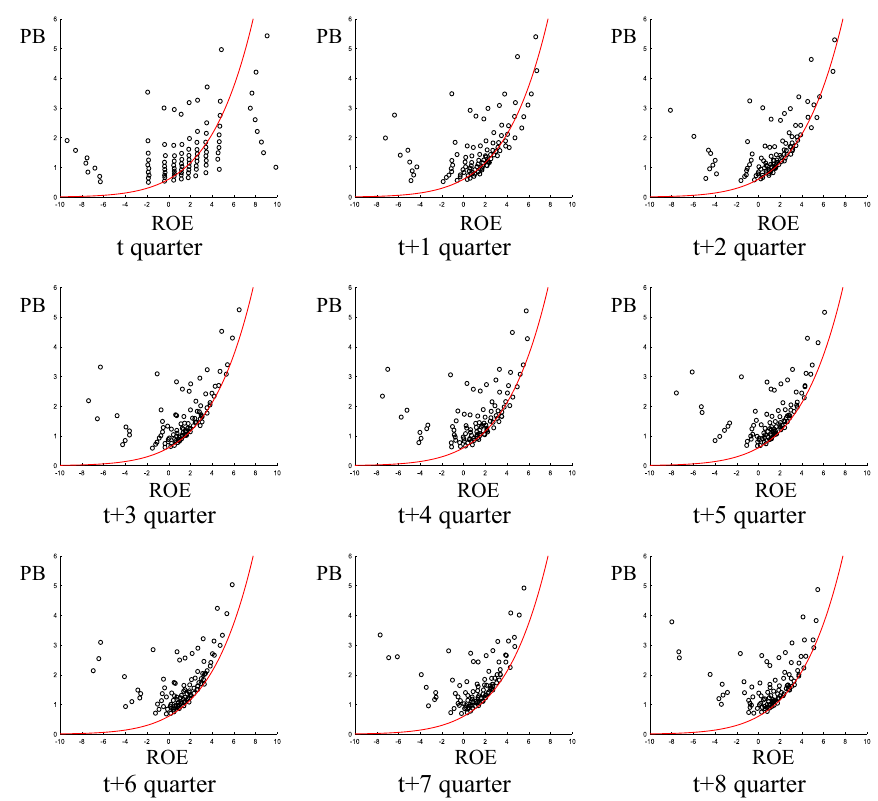
Fig. 8 Return on Equity (X axis) and Price‑to‑Book value ratio (Y axis) in the t quarter and the subsequent t 1, t 2,…, t 8 quarter after the portfolios are + + +